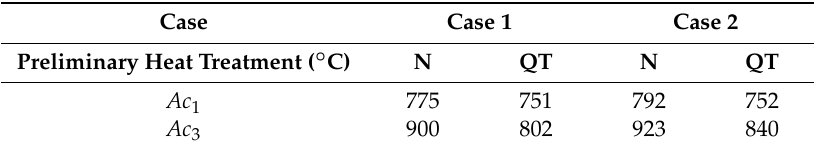
Table 9. Heating rate-dependent computed austenitization temperatures Ac 1 and Ac 3 under the quasi steady state assumption.